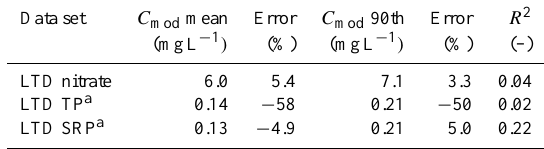
Table 5. Nutrient modelling results from “expert” calibration in the baseline scenario (1997–2006 a )